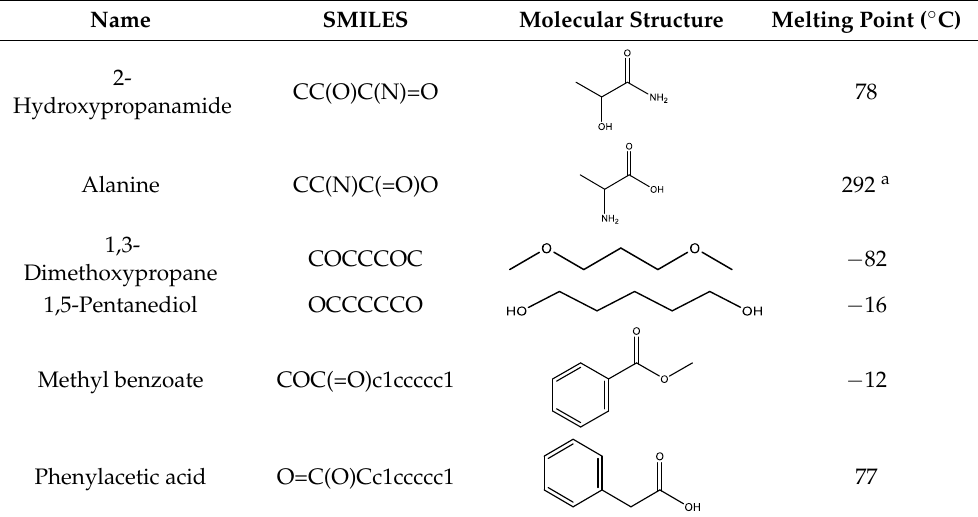
Table 5. Names, SMILES, molecular structures, and melting points of isomers.